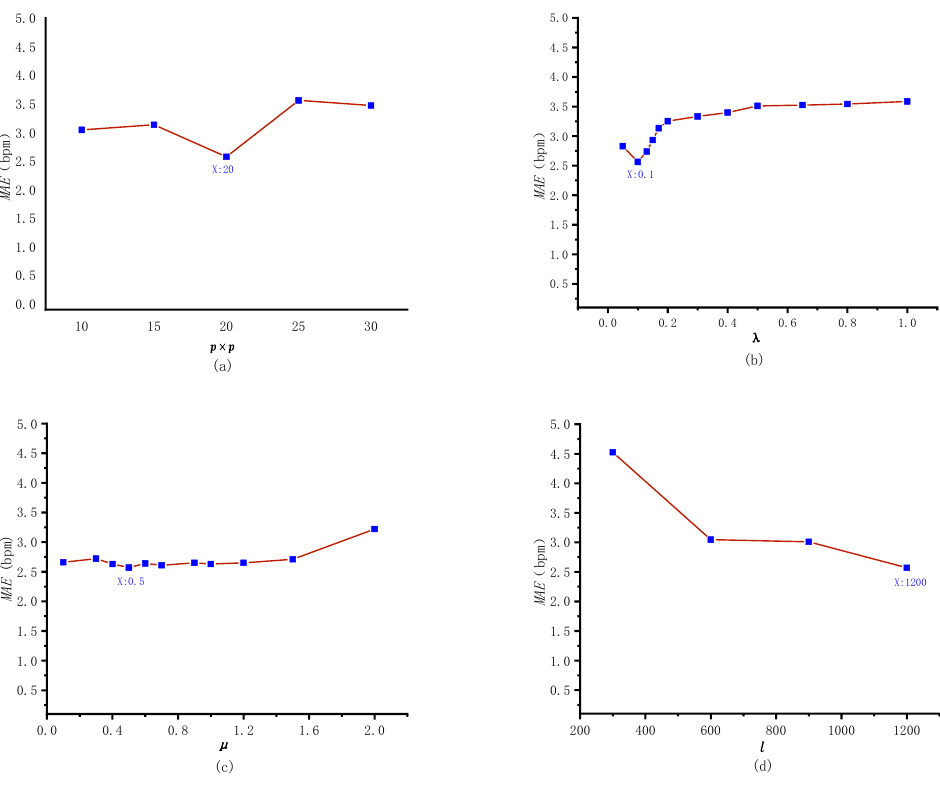
Figure 7. The parameterization of SSR2RPS. ( a ) Size of the sub-region. ( b ) Smoothing parameter of baseline elimination. ( c ) Penalty coefficient of SSR. ( d ) Video